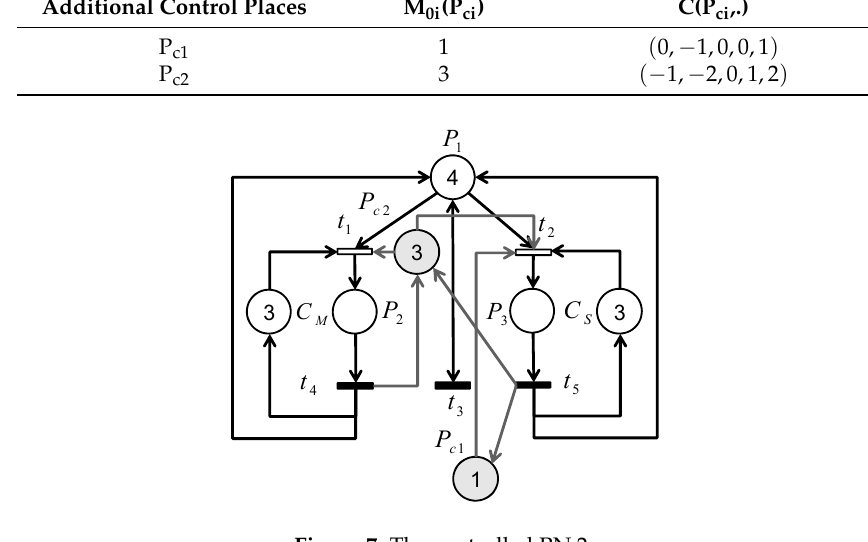
Figure 7. The controlled PN 2. Table 6. Forbidden markings (P 2 P 3 ) of Example 2.